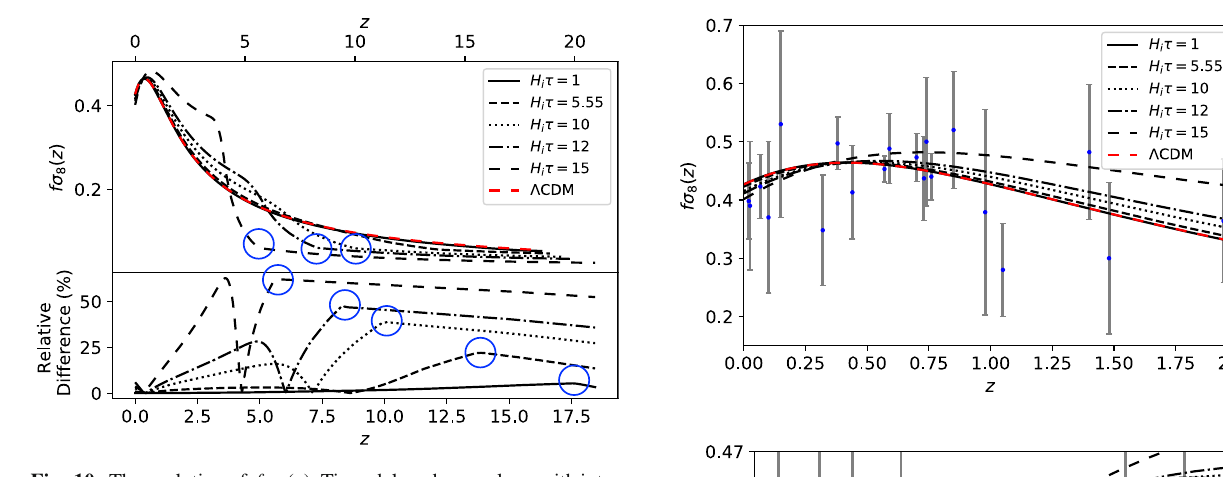
rally, we also find that delays on the order H i τ (cid:2) 1 lead to f σ 8 ( z ) predictions that are indistinguishable from Λ CDM.